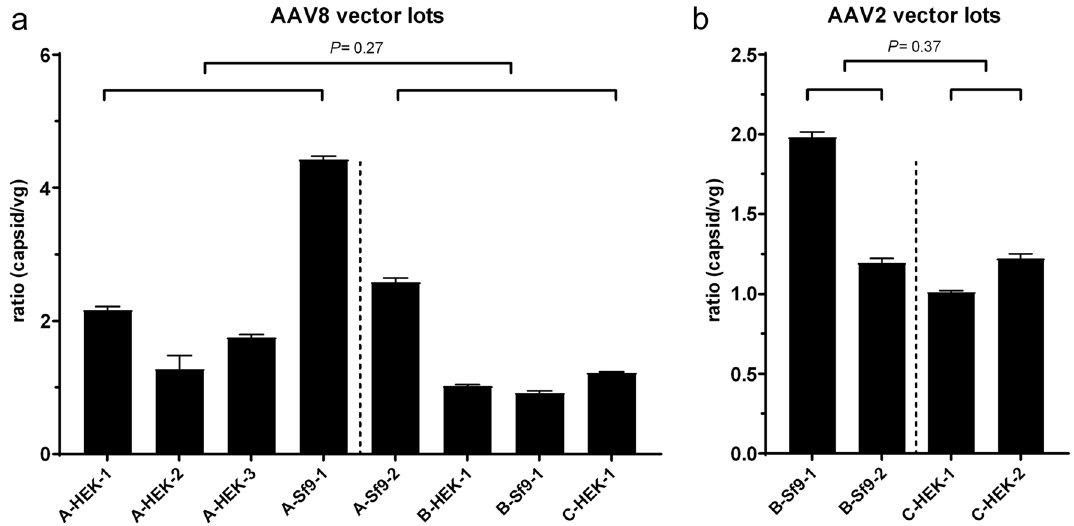
Figure 2. Comparison of capsid/vg ratios between different AAV8-CMV-eGFP and AAV2-CMV-eGFP vector lots. The capsid/vg ratios derive from absorbance measurements (ELISA) and ddPCR results of ( a ) eight AAV8 vector lots and ( b ) four AAV2 vector lots. Dashed lines separate “immunogenic” from “non-immunogenic” AAV vector lots. Bars indicate means and standard deviations of replicates. Statistical significance was determined using unpaired Student